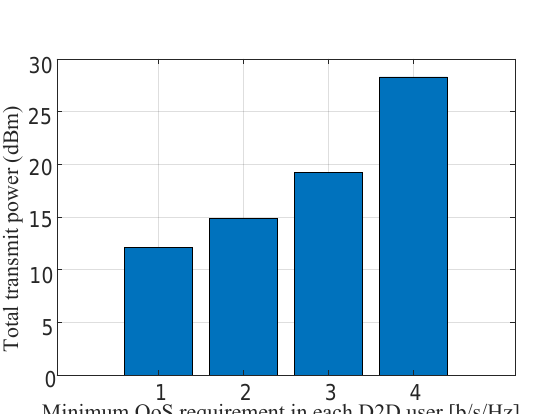
Figure 4. Total transmit power for minimum QoS requirement